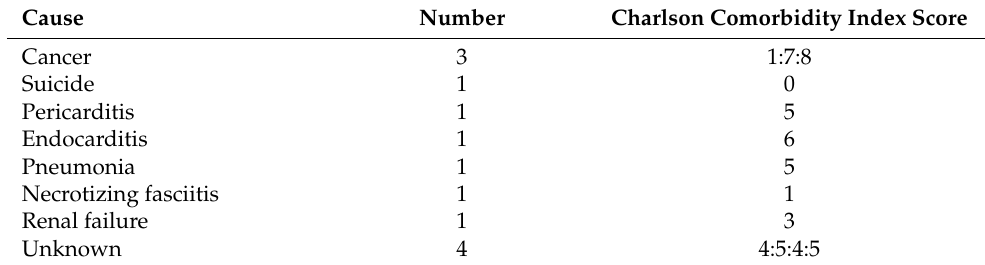
Table 7. Causes of death.